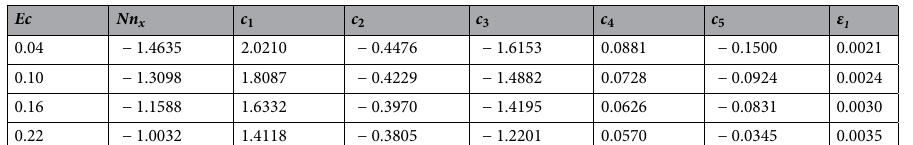
Table 6. Quadratic regression approximated coefficients of Sf x owing to variations in S and L and optimum relative error bound ε are tabulated as mentioned below.